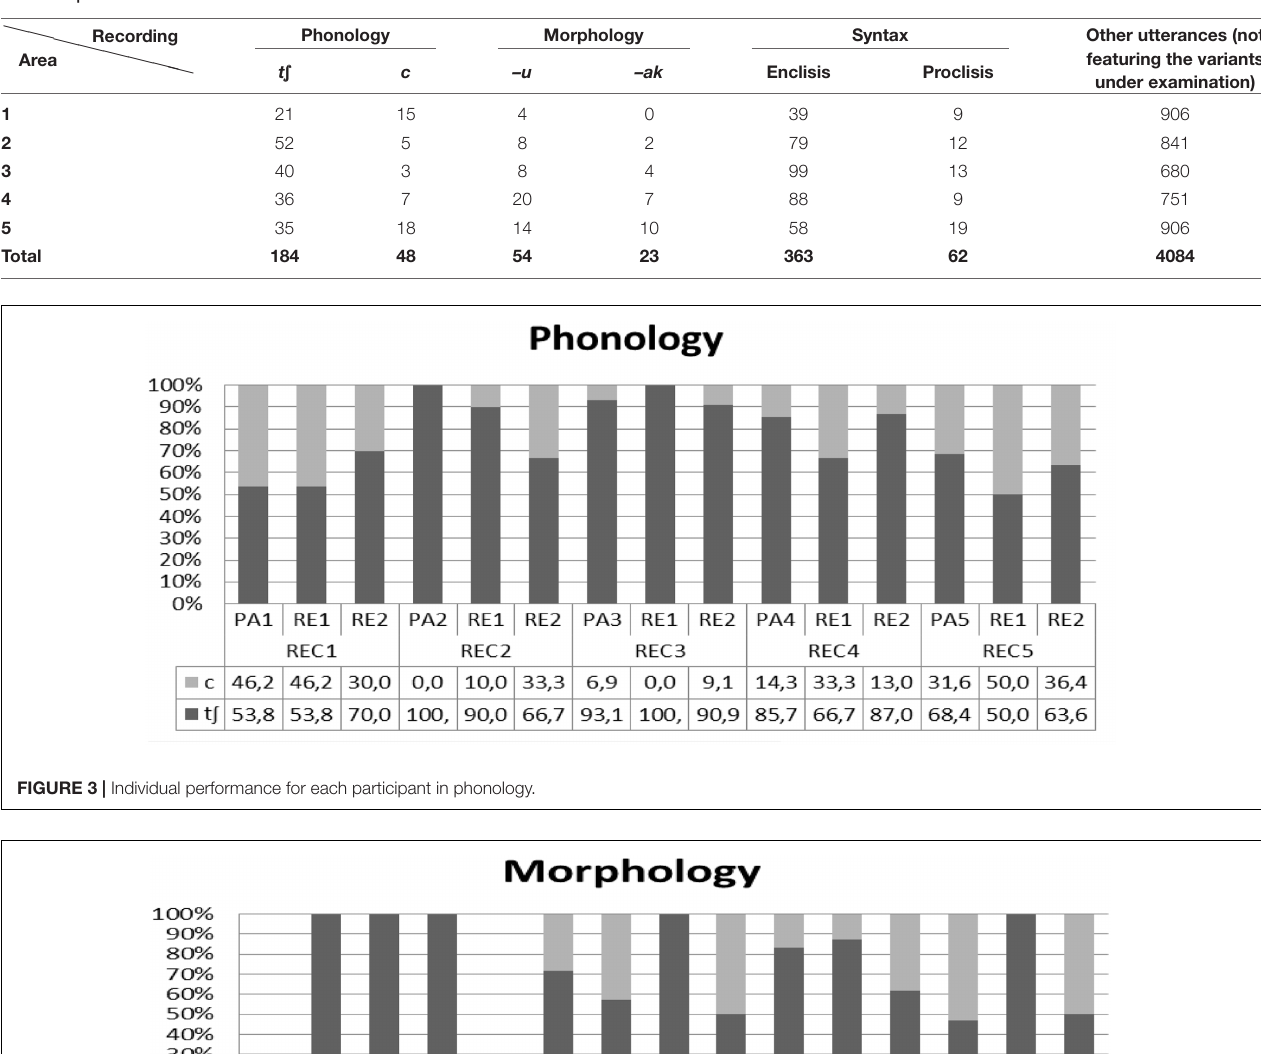
TABLE 2 | Calculated items.